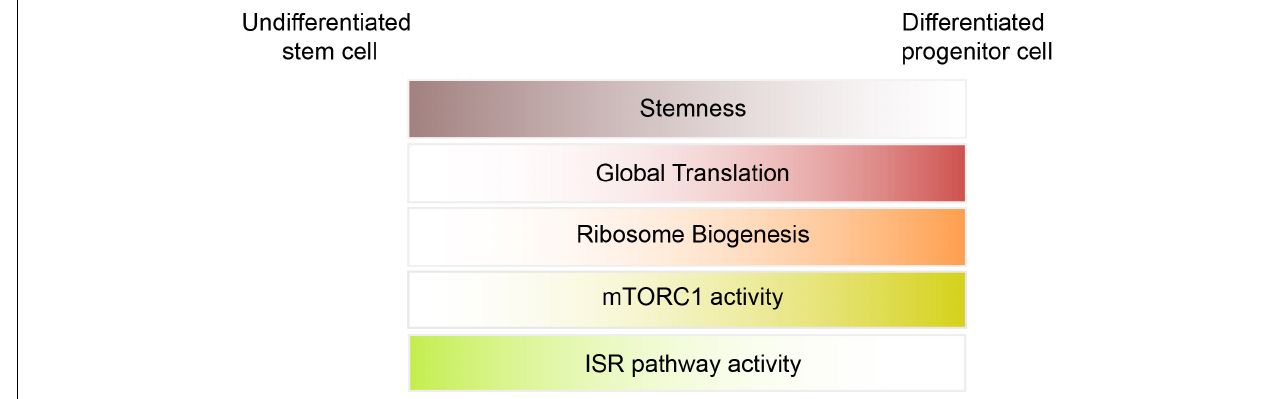
FIGURE 2 | Underlying mechanisms of translation inhibition in stem